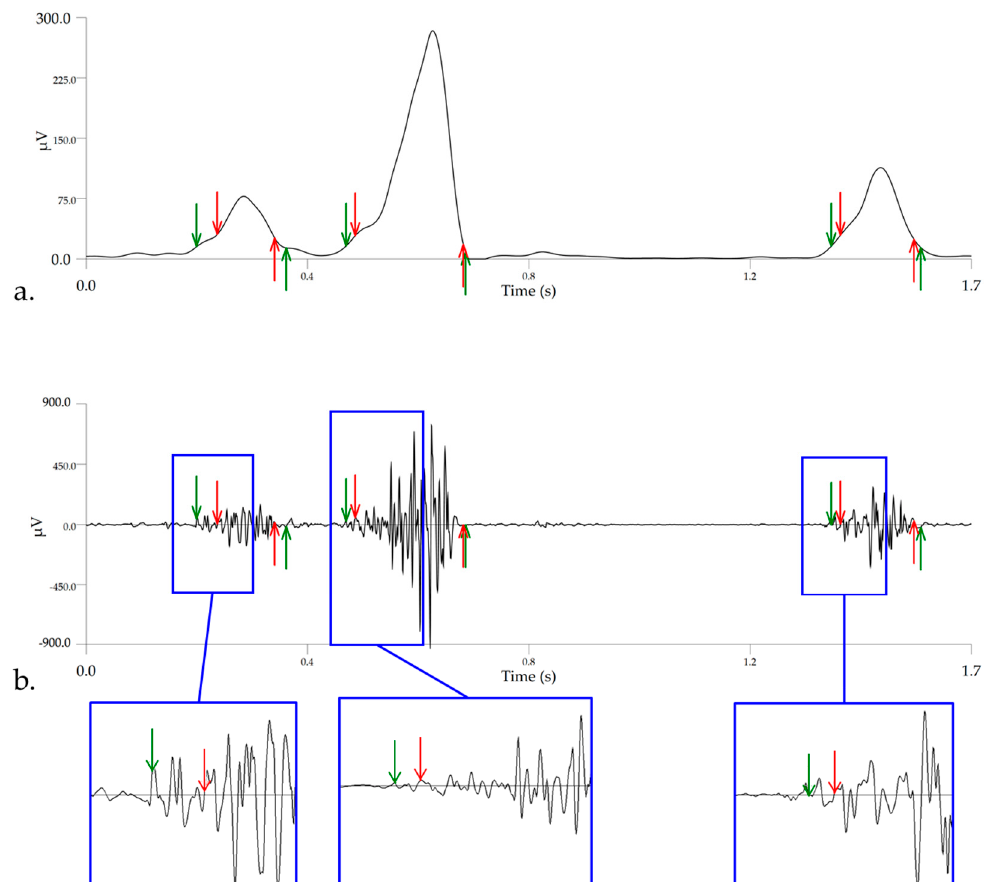
Figure 3. A comparative example of the improved accuracy of biceps femoris activity onset (downward arrows) and offset (upward arrows) events when a 5% amplitude threshold (green arrows) is employed compared to the 10% amplitude threshold (red arrows). ( a ) shows the enveloped sEMG signal (Butterworth 4th order low-pass filter, 10 Hz cut-off) employed for event detection, with ( b ) showing the same events applied to high-pass filtered data (40 Hz cut-off) to illustrate the accuracy of events.